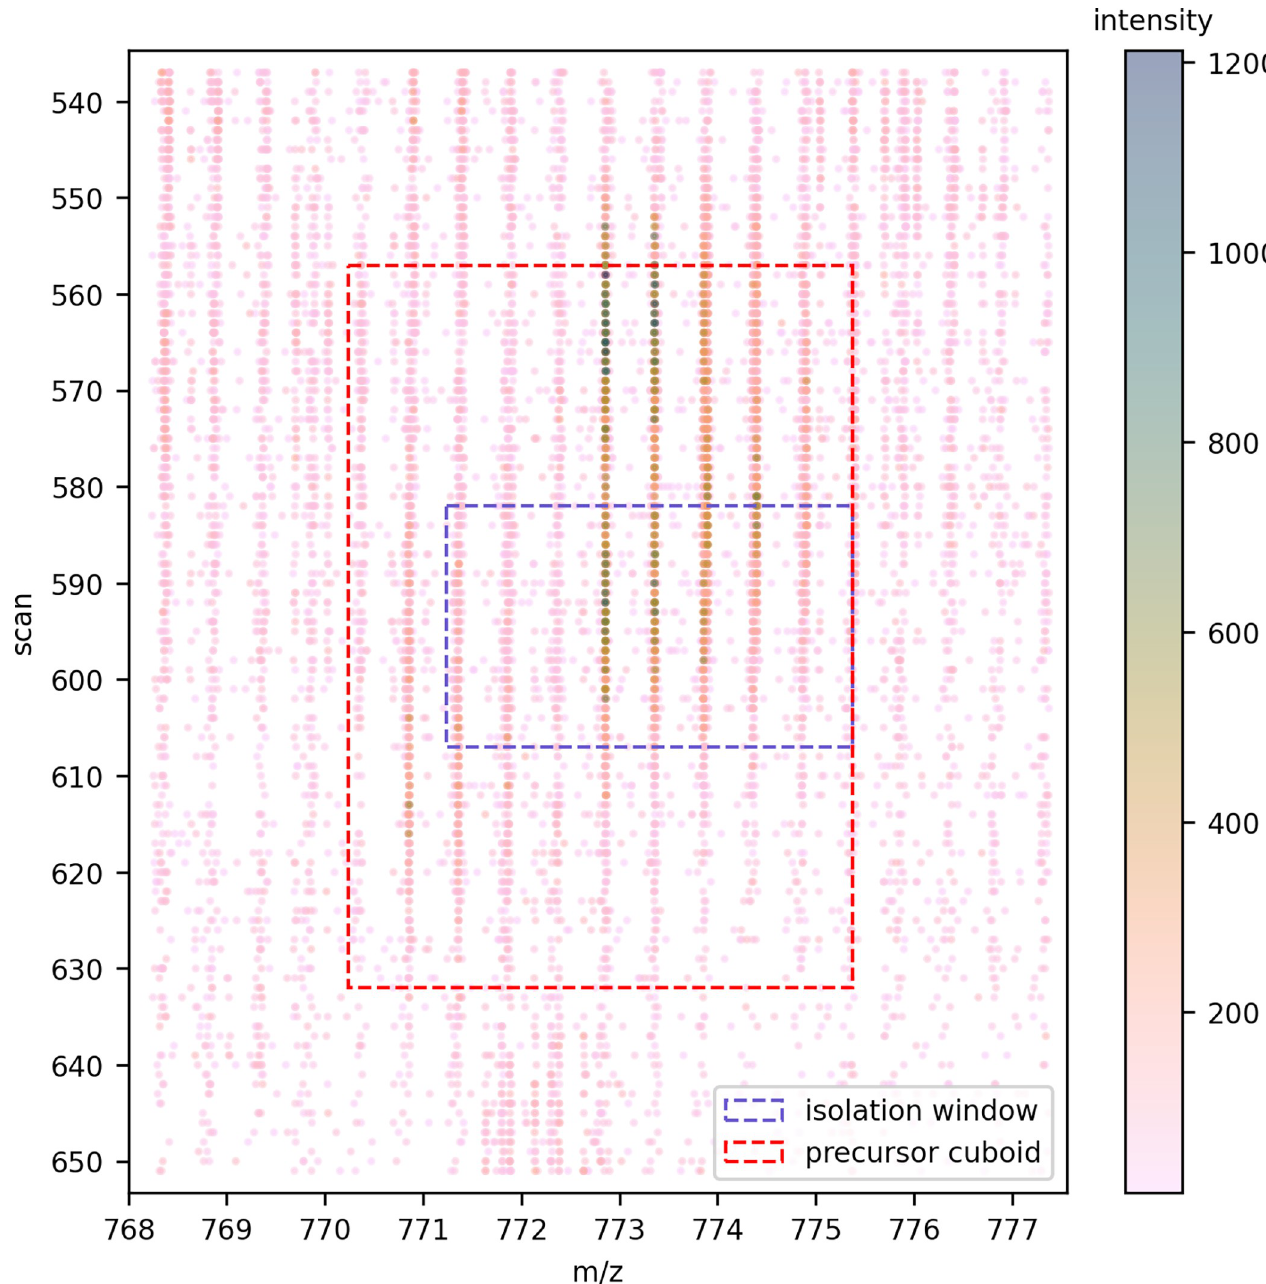
Fig 2. Formation of the precursor cuboid from the isolation windows recorded by the instrument for each precursor ion selected for fragmentation. Note the points shown are from all the frames in which this precursor was selected.